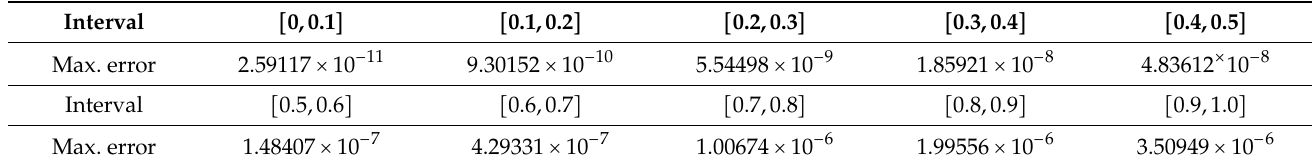
Table 2. Approximation errors for the scalar problem given in Equation (30).